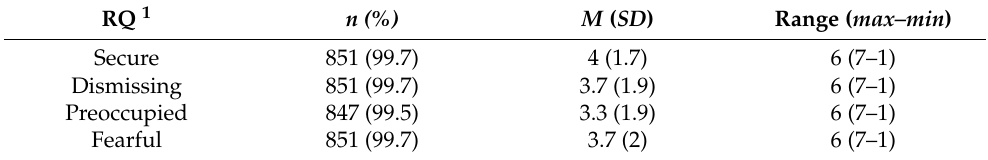
Table 2. Descriptive statistics of the Relationships Questionnaire (RQ)